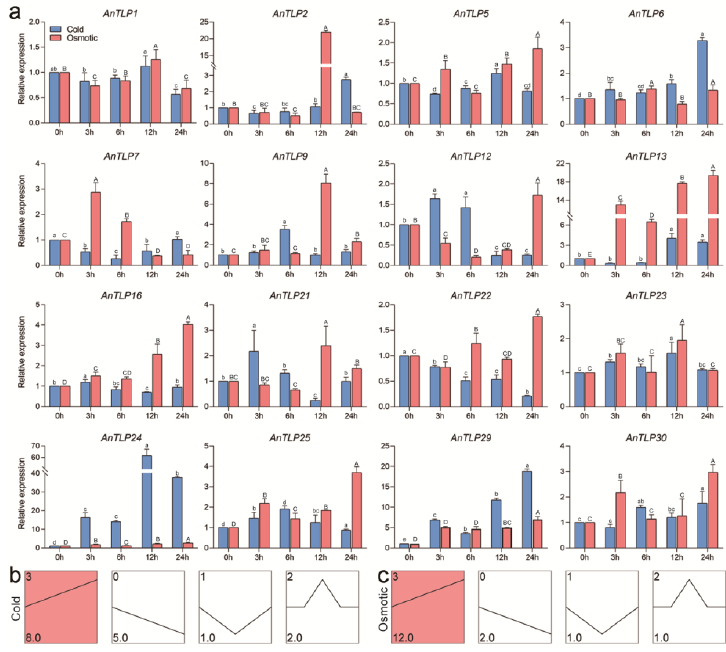
Figure 9. Expression patterns of AnTLP genes under cold and osmotic stress. ( a ) Analysis of temporal expression patterns of AnTLP genes under cold and osmotic stress; blue represents cold stress and red represents osmotic stress. The eIF1 gene was used as the internal control gene. The signifi- cance between the data of the cold-stress experimental group is marked with lowercase letters, and the significance between the data of the osmotic stress experimental group is marked with upper- case letters. There is no significant difference between the data sharing the same letters; conversely, there are significant differences between the data. ( b ) Trend analysis of AnTLP genes expression patterns under cold stress. ( c ) Trend analysis of AnTLP genes expression patterns under osmotic stress. The colored segment is a significantly enriched module. The number in the upper left corner of the module is the number of the module, and the number in the lower right corner represents the number of genes belonging to the module. 2.7. Overexpression of AnTLP13 Gene Enhanced the Tolerance to Low-Temperature Stress in E. coli and Yeast E. coli and yeast growth assay was performed to evaluate the effect of the AnTLP13 gene on the tolerance of E. coli and yeast to low-temperature stress. The AnTLP13 protein bands were found in SDS-PAGE gel, indicating that the AnTLP13 gene was successfully expressed in E. coli cells (Figure 10a). The growth curve of E. coli transformed with empty plasmid (CK) was almost coincident with that of E. coli overexpressing AnTLP13 , indicat- ing that overexpression of AnTLP13 did not affect the growth of E. coli under normal growth conditions (Figure 10b). When cultured at 28 °C, the growth rate of E. coli slowed down, and overexpression of the AnTLP13 gene effectively alleviated the inhibitory effect of cold on the growth of E. coli cells (Figure 10c). Repeated freeze – thaw treatment resulted in the mass death of E. coli cells, and overexpression of the AnTLP13 gene significantly increased the survival rate of E. coli after repeated freeze – thaw treatment (Figure 10d). After repeated freeze – thaw treatment, the survival yeast expressing the AnTLP13 gene (recorded as AnTLP13) was significantly higher than the yeast transformed with the pYES2 empty plasmid (recorded as CK) (Figure 10e). The above results showed that over- expression of the AnTLP13 gene enhanced the tolerance to low temperature in both E. coli and yeast.